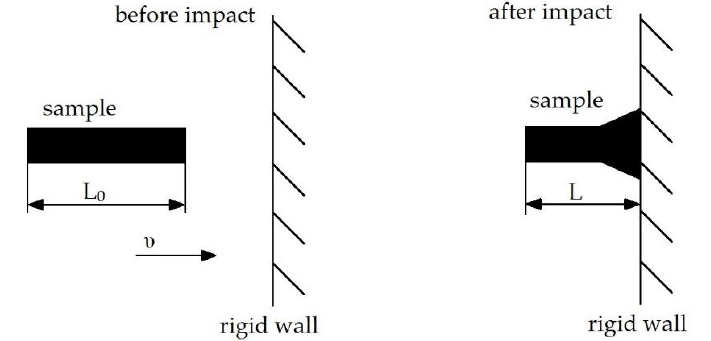
Figure 1. Schematic of the classic Taylor impact test.